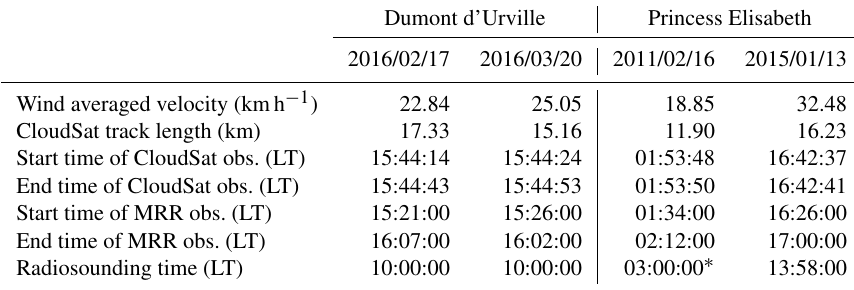
Table 1. Weather conditions and instrumental characteristics for the DDU and the PE stations. Wind velocity is vertically averaged over the first 3km of the atmosphere. Times are converted from UTC and displayed in local time (LT); the DDU station is UTC + 10 and the PE station is UTC + 03. The asterisk denotes that weather conditions were retrieved from ERA-Interim profiles instead of a radiosonde. The date format is